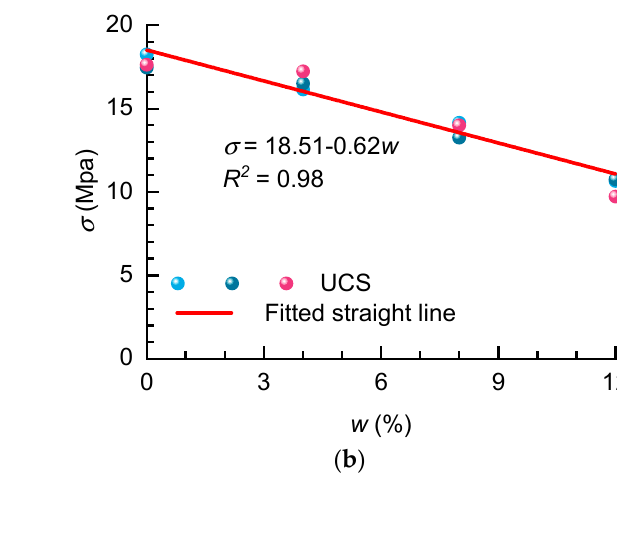
Figure 6. Water content–immersion time